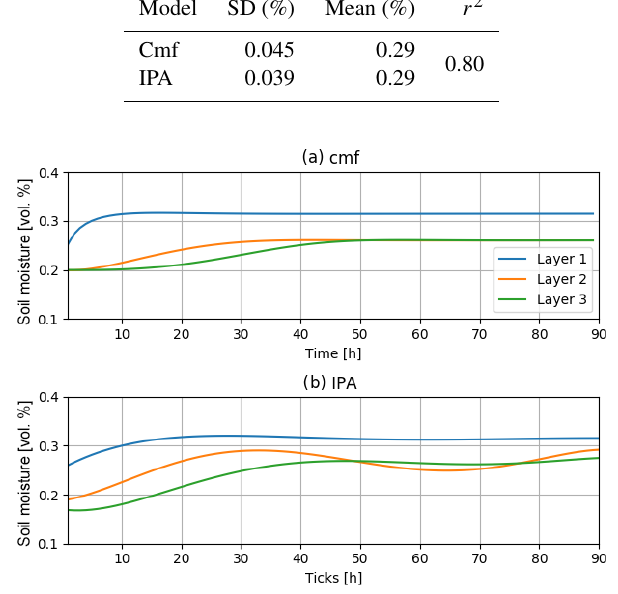
Figure 4. Comparison of soil moisture development of the up- most three layers with a transition boundary between Layer 1 and Layer